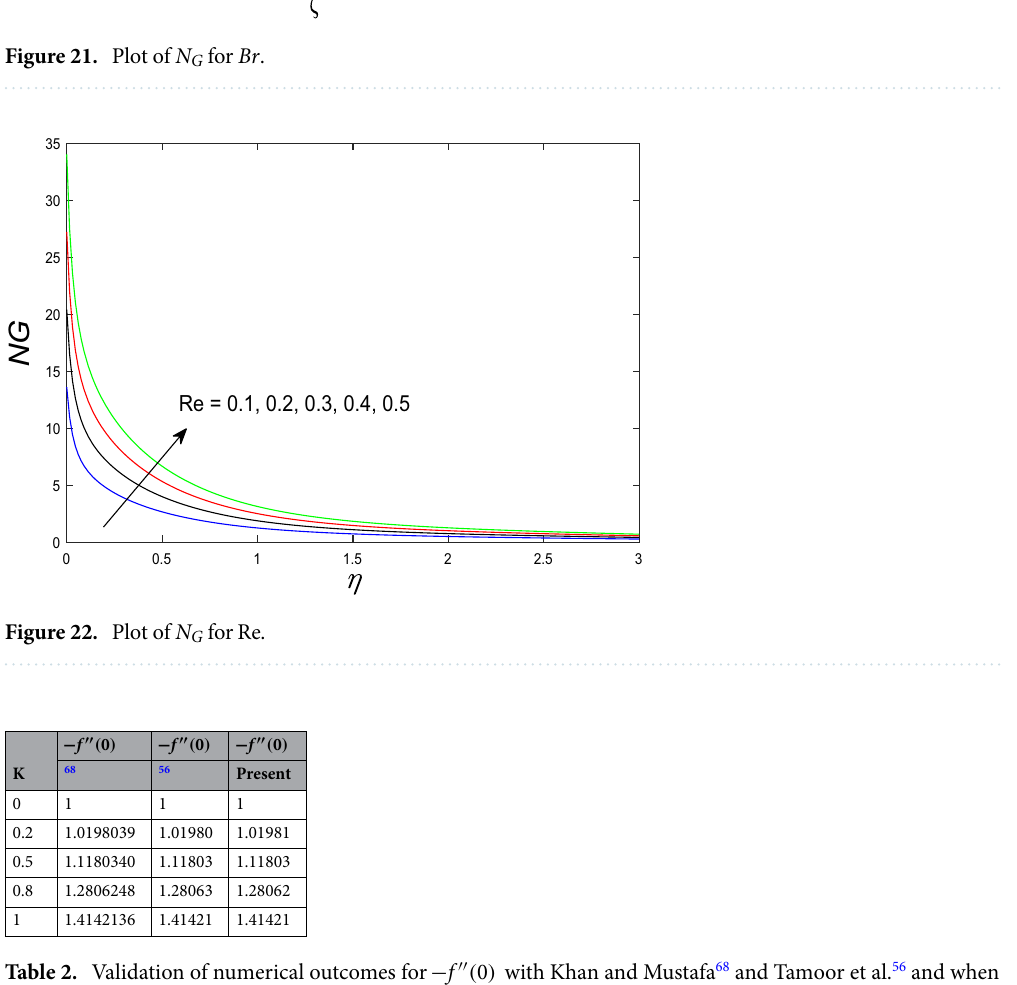
Table 2. Validation of numerical outcomes for M = B 1 =